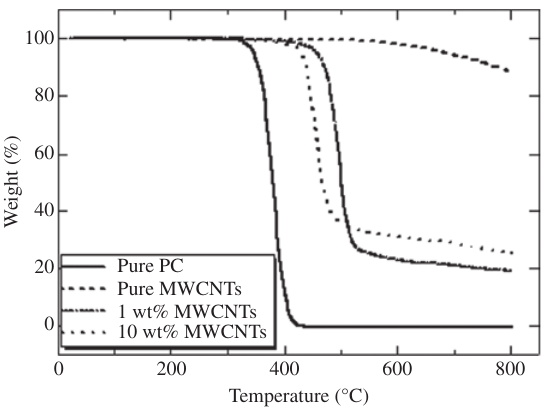
Figure 4: TGA curves of pure PC, MWCNT, and MWCNT/PC compo- sites obtained at the injection temperature of 280 ° C and injection speed of 10 mm/s.